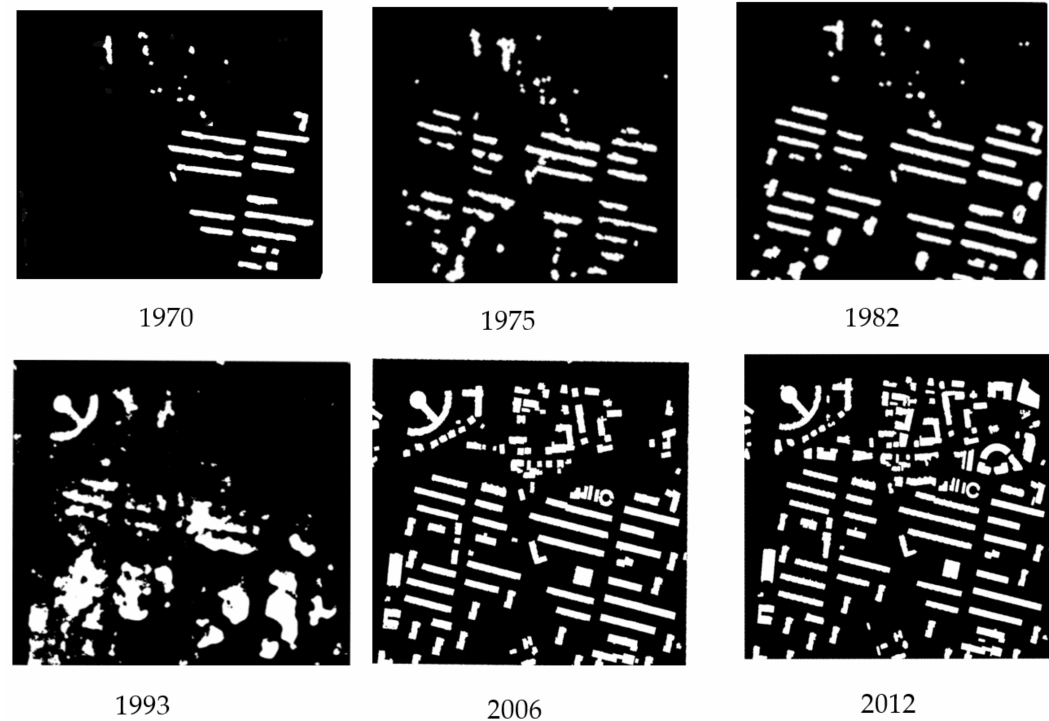
Figure 9. Detection results obtained for all of the considered years.